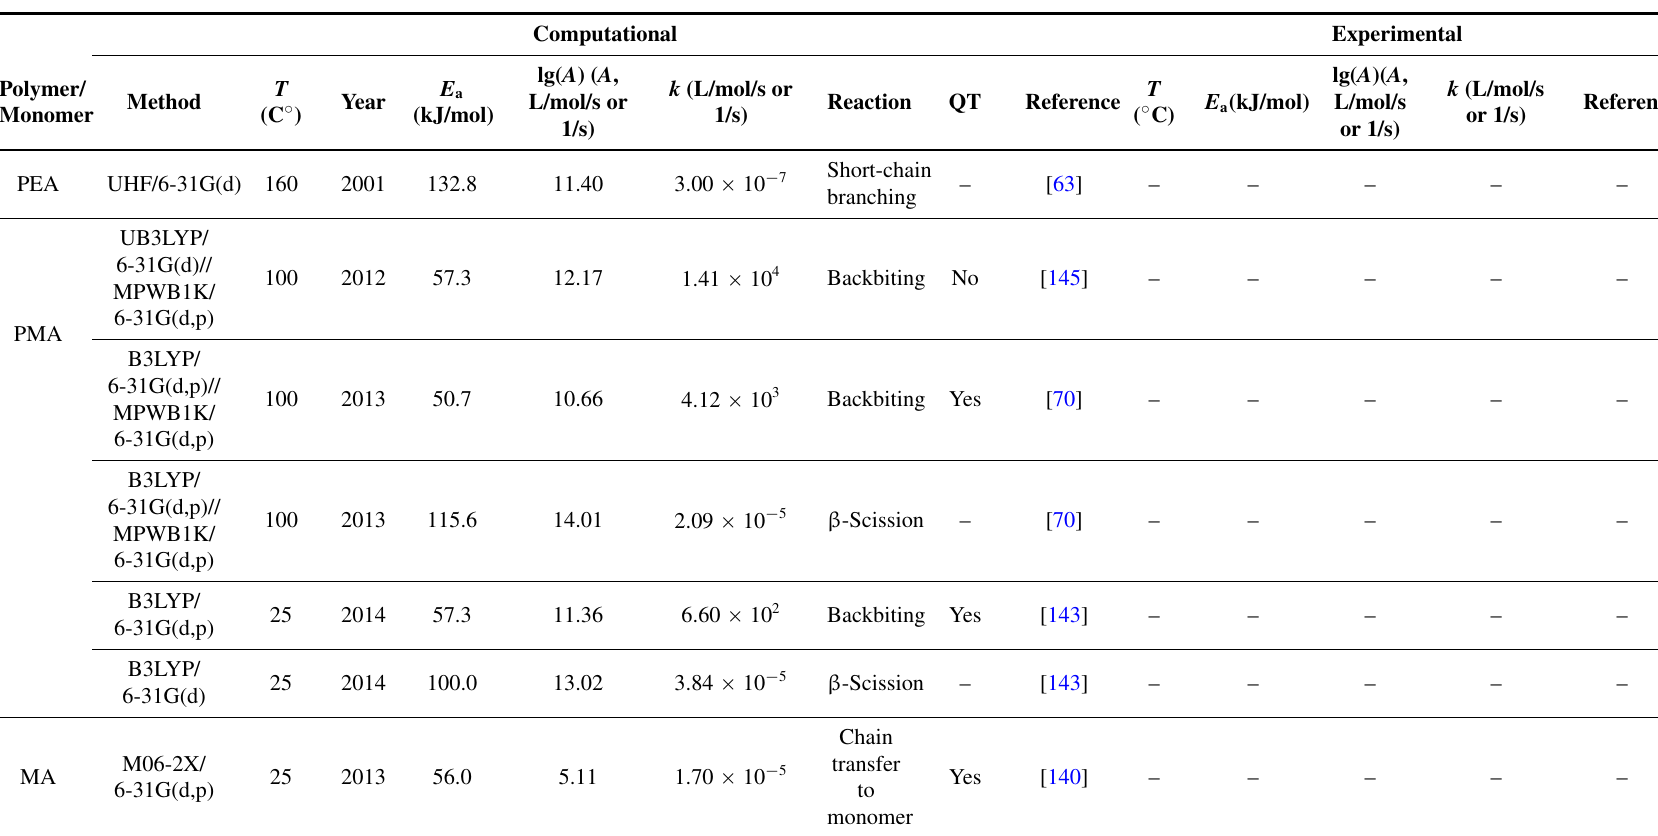
Table 4. Rate coefficients, k , and Arrhenius parameters (activation energy, E relevant free radical polymerization systems estimated by QC and comparison with the existing data obtained through PLP experiments. The reported rate coefficients are evaluated at the indicated temperatures ( T